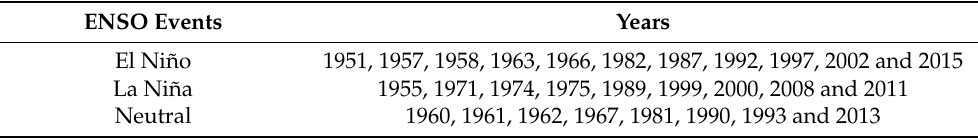
Table 1. Identified ENSO years during